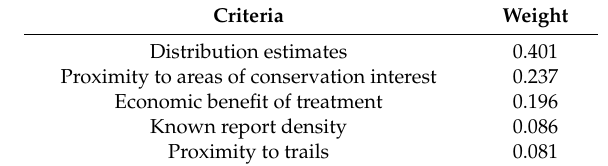
Table 2. Criterion weighting as determined via the analytic hierarchy process (AHP).